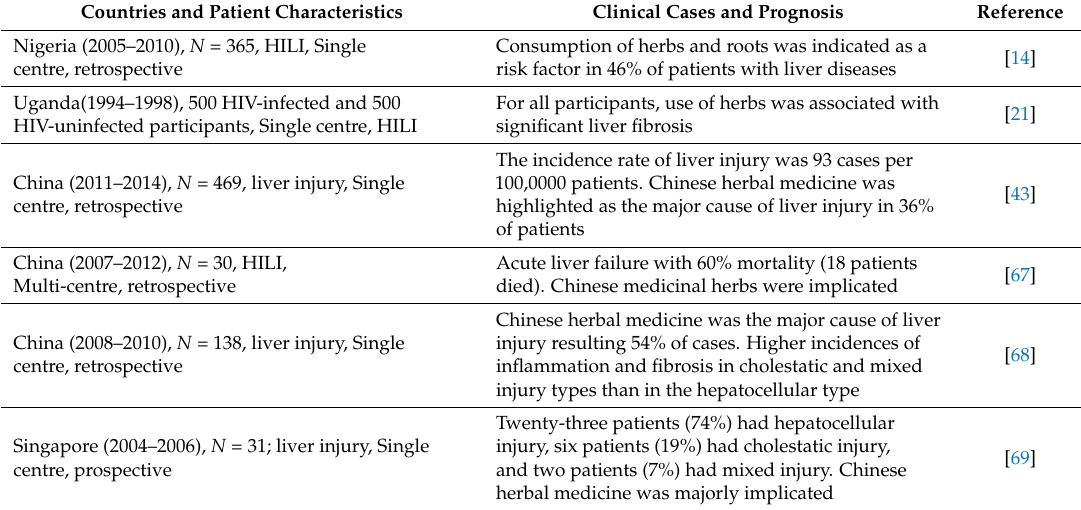
Table 2. Selected clinical case reports of HILI in developing